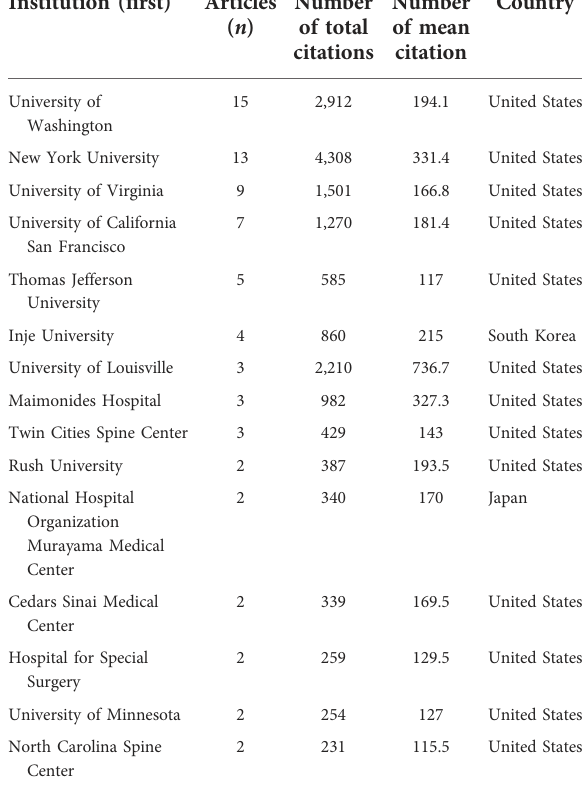
TABLE 3 The institutions providing two papers or more to the most highly cited ASD